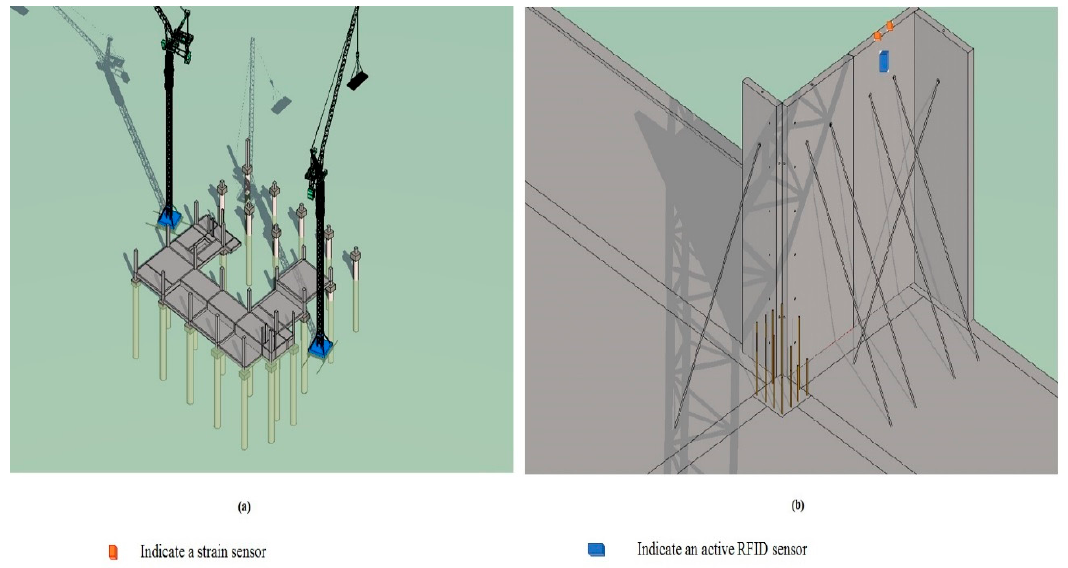
Figure 24. ( a ) BIM model of the PC project; ( b ) BIM model of a PC wall panel holding on site.